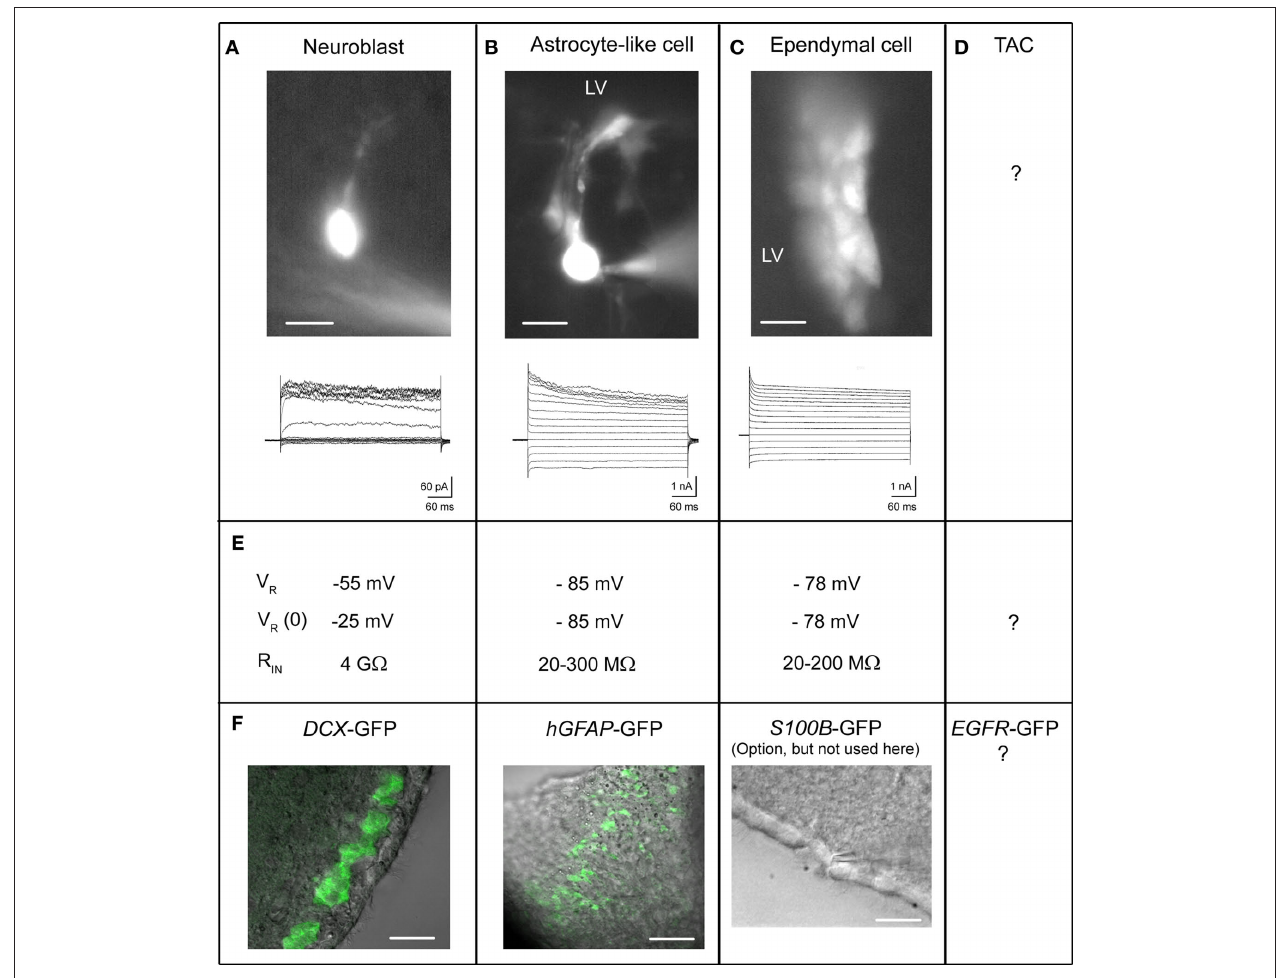
Figure 4 | electrophysiological properties of SVZ cells. (A–D) Each column corresponds to the properties of the following cell type: neuroblasts (A) , astrocyte-like cells (B) , ependymal cells (C) , and the uncharacterized TAC (D) . Live image of Lucifer yellow-filled cells during patch clamp recording are shown for each. (e) Biophysical properties including resting potential V